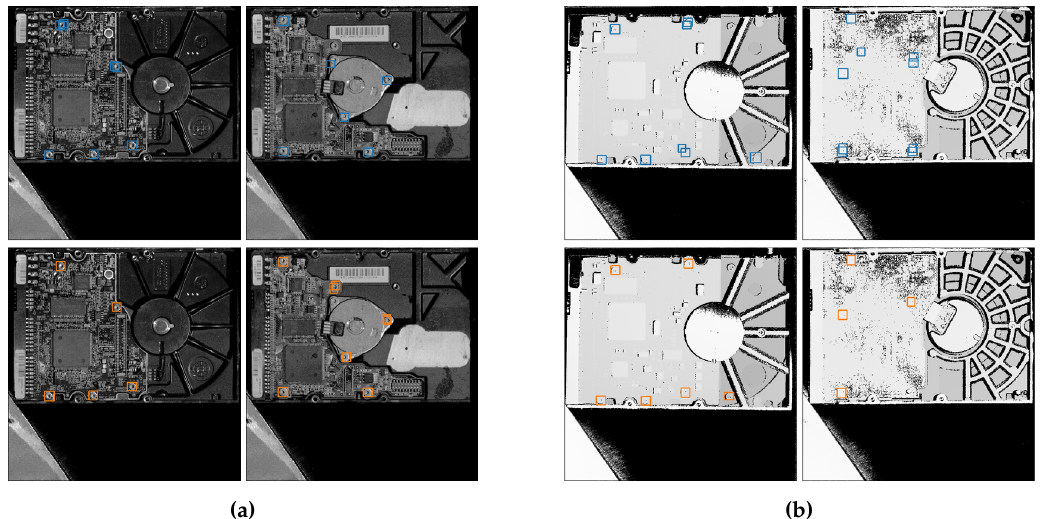
Figure 7. Example images from the test set of the GD Screws dataset. Detections from our best fusion model (GD_21) are shown in comparison with our baseline Grayscale and D models. ( a ) Resulting detections of our Grayscale model (top images—blue boxes) and best fusion model (bottom images—orange boxes). ( b ) Resulting detections of our Depth model (top images—blue boxes) and best fusion model (bottom images—orange boxes).